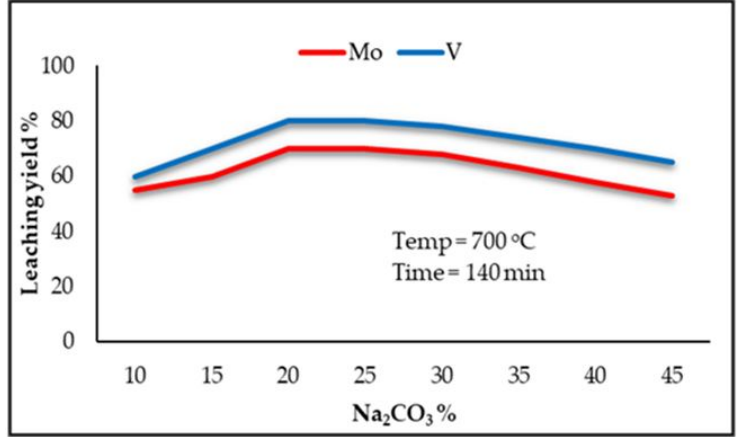
Figure 2 . Leaching of molybdenum and vanadium vs. soda ash